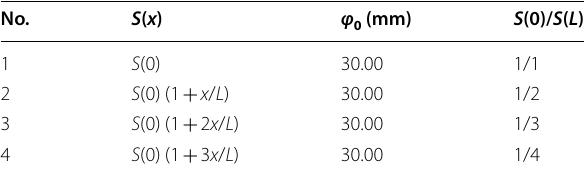
Table 1 Geometrical dimensions of the non-uniform rotating shafts